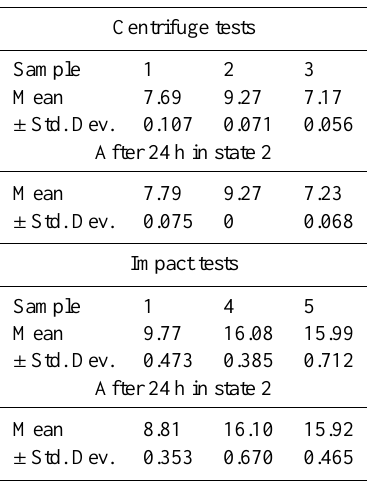
Figure 9. Mean threshold accelerations for each sample, shown for the first set of tests and for the second set, after remaining for 24h in the second stable state. Table 2. Sample means and standard deviations for all 8 ◦ configu- ration tests, reported in